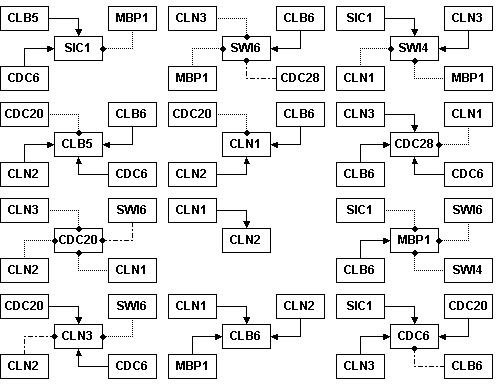
Best Fit Model of Yeast Cell Cycle Interactions. Diagram of the best fitting gene interactions for each node gene, as shown in Table 3. Solid lines ending in an arrow represent positive interactions (induction, e.g., [1 2 3], [1 3 3], etc.), dotted lines ending in a closed circle represent monotonic negative interaction (repression, e.g., [3 2 1], [3 1 1], [1 1 2], etc.), and dash-dot lines ending in a diamond represent an interaction that is both positive and negative (e.g., [3 1 3], [1 3 1], etc.).